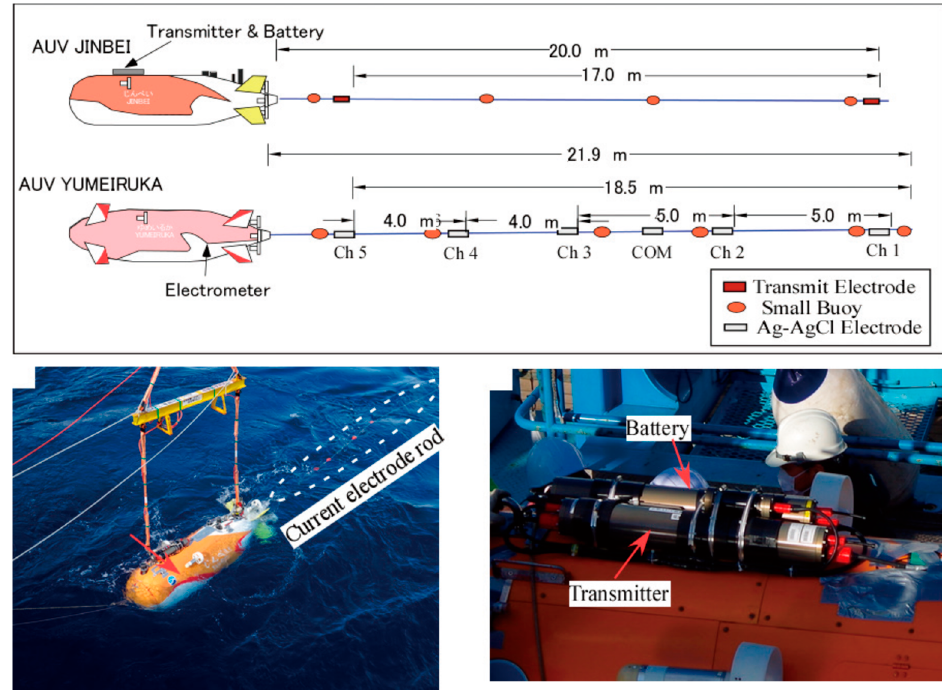
Figure 37. Sketch of exploration using two autonomous water vehicles (AUVs) and an autonomous surface vehicle (ASV) (see Kasaya et al., 2020 [116], for details). These types of equipment could be revolutionary for the exploration of ore bodies at the seafloor by using a combination of self ‐ potential, resistivity, and induced ‐ polarization data. Since the methods have different sensi ‐ tivities with respect to the ore bodies, the combined tomograms could provide a highly efficient method to image ore bodies at the seafloor.